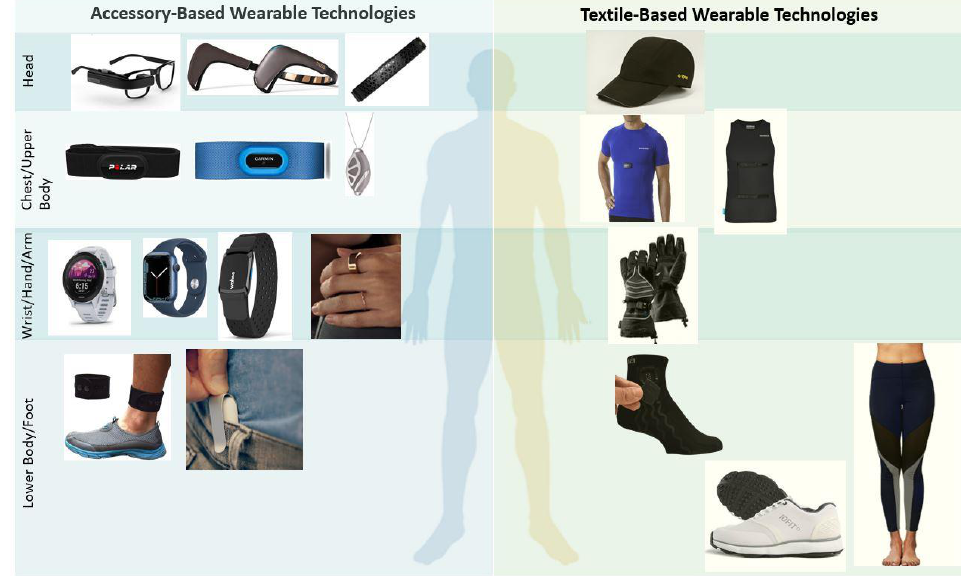
Figure 3. Market research for accessory-based and textile-based wearable technologies.